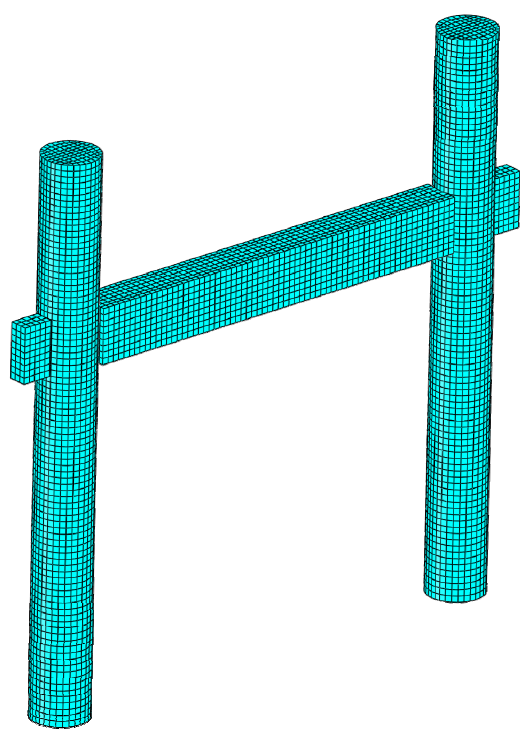
Figure 6. Finite element (FE) model.